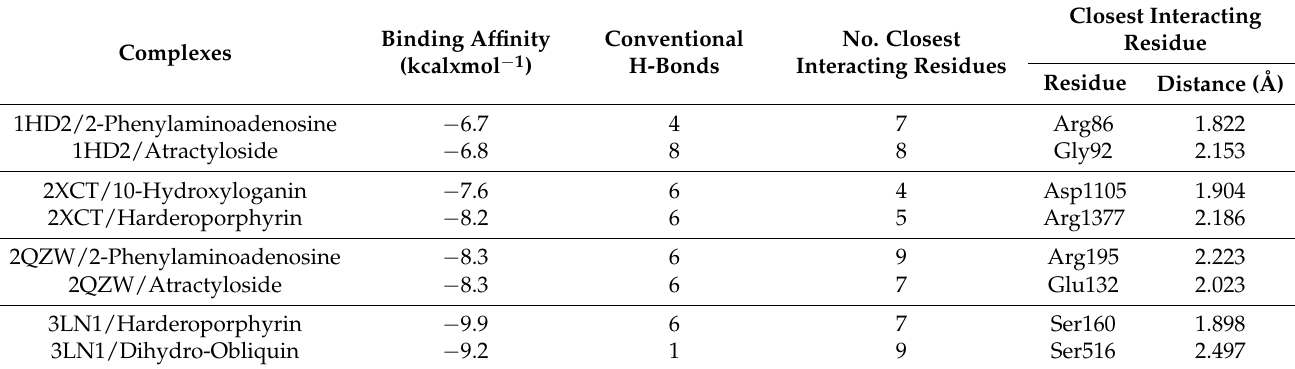
Table 6. Binding affinity, conventional hydrogen-bonding, the number of closest interacting residues and distance to closest interacting residue (Å) of some compounds with best scores with the different targeted receptors (1HD2, 2XCT, 2QZW, and 3LN1).